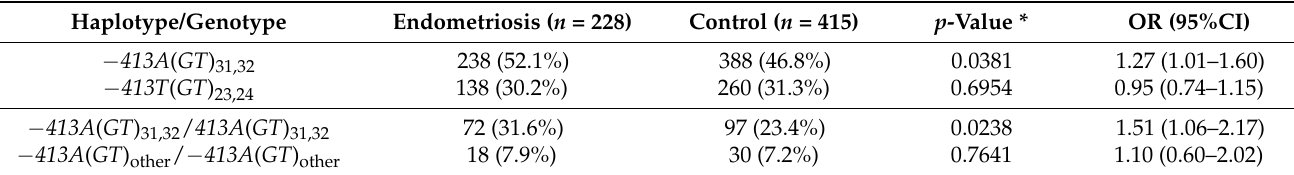
Table 3. Distribution of two major HMOX1 − 413A>T ( GT ) n haplotypes and genotypes in patients with endometriosis and control women.